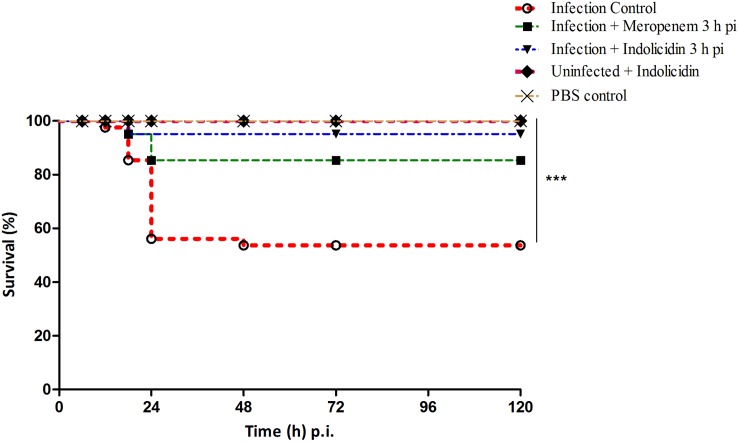
Survival of G. mellonella larvae infected with LD50 dose of MDR-EAEC strains (106 CFU) and treated with MIC dose of Indolicidin 3 h post-infection. MDR-EAEC induced infection (10 μL) was treated with MIC dose of Indolicidin (10 μL), keeping respective controls (infected, infected with meropenem-treatment, AMP control, PBS control). Data expressed as the mean of three independent experiments. Survival curves were plotted using the Kaplan–Meier method and statistical analysis were performed using the log-rank test for multiple comparisons (GraphPad Software, San Diego, CA, United States). ∗∗∗P < 0.001.